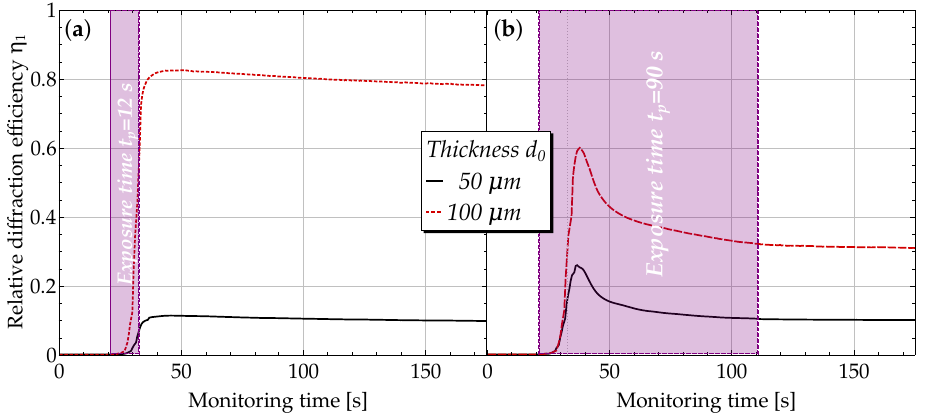
Figure 4. The +1st order relative diffraction efficiencies at the Bragg angle as a function of time for samples with a recording exposure of ( a ) t p = 12 s and ( b ) t p = 90 s, respectively. The readout wavelength was λ r = 633 nm.